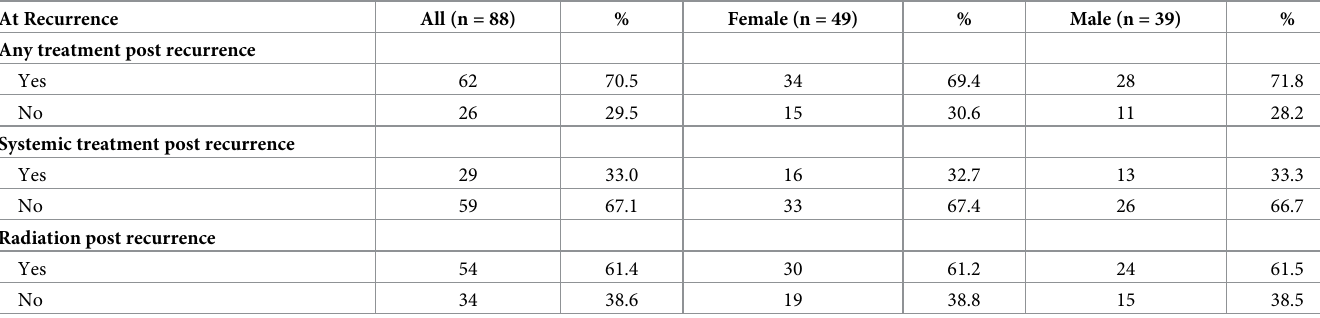
Table 2. Treatments received after recurrence for all patients and by gender.